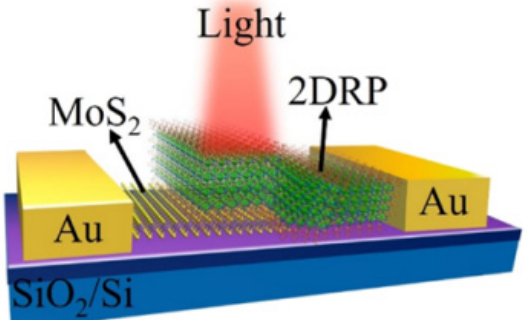
Figure 16. Schematic illustration of waveguide-integrated 2D LED based on monolayer WSe 2 and CdS nanoribbon p − n heterojunction. (Reproduced with permission from ref. [164]. Copyright 2022 ACS Publications).